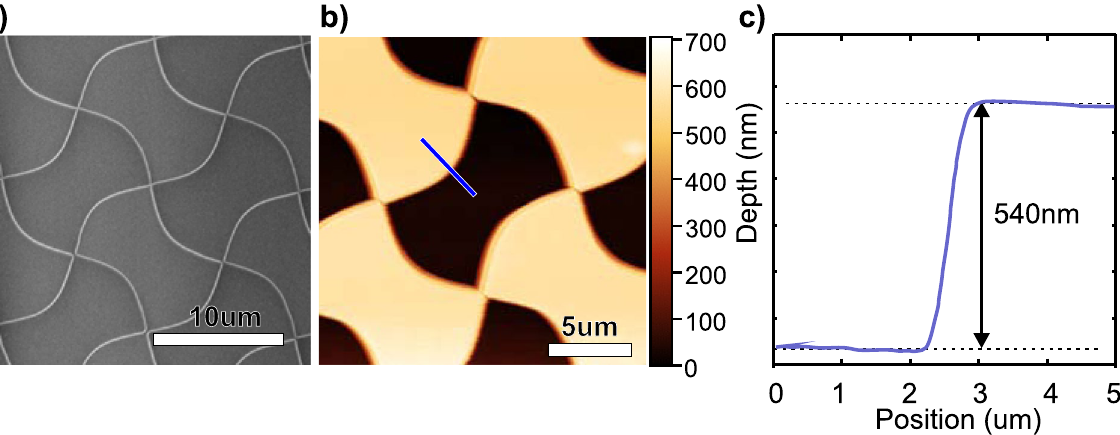
Figure 3. Fabrication and characterization of the 0.84 × π grating. ( a ) Electron microscopy image of the resulted grating showing a good border definition of the different etching zones. ( b ) Scanning AFM image of the heights of the gratings as a convolution of the physical size of the tip and the real structure of the grating. The cross section along the blue line is presented in ( c